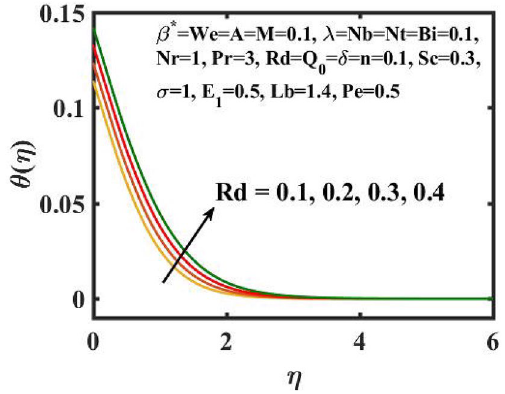
Figure 9. Encouragement of Rd on θ(η) .